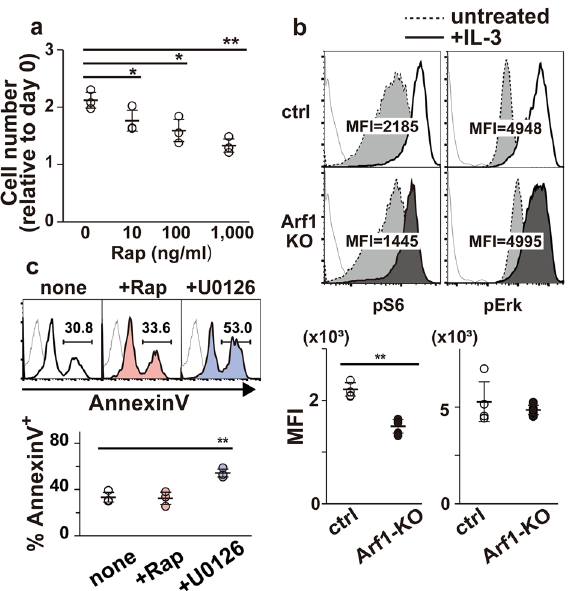
Figure 3. The mTORC1 signal is decreased in Arf1-deficient BMMCs. ( a ) Control BMMCs at 5-week after culture (n = 3) were stimulated with IL-3 (10 ng/ml) along with the indicated concentration of rapamycin (Rap) for 5 days. The cell numbers were determined using Cell Counting Kit-8 and shown relative to the cell numbers at day 0 (mean ± SD). ( b ) Either control (ctrl; n = 4) or Arf1-KO (n = 6) BMMCs were pretreated without IL-3 for 18 h, stimulated without (dotted line) or with (solid line) 10 ng/mL of IL-3 for 20 min, and assayed for pS6 (left) and pErk (right) signals by FACS. Shown are representative FACS profiles (top) and mean fluorescence intensities (MFI) (bottom). Gray thin lines on FACS plot indicate negative stained signal with isotype controls. Mean ± SD. ( c ) Control BMMCs depleted of Annexin V + cells were cultured in the presence of 10 ng/mL IL-3 without (none) or with 0.1 µM of rapamycin (+ Rap) or 10 µM of U0126 (+ U0126) for 3 days (n = 3, each). The proportions of Annexin V + cells were evaluated by FACS. Shown are representative FACS profiles (top) and proportions (bottom). Gray thin lines on FACS plot indicate negative stained signal with control reagents. Mean ± SD. * p < 0.05, ** p <